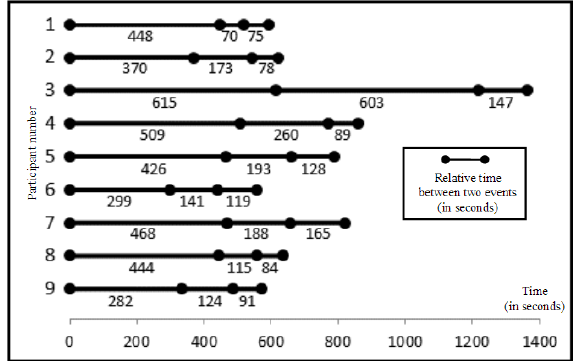
Figure 1. Time taken by Bioshock 2 players between four key moments of the game: first power acquirement, first encounter with the "boss", second encounter with the "boss", external vision of the city.